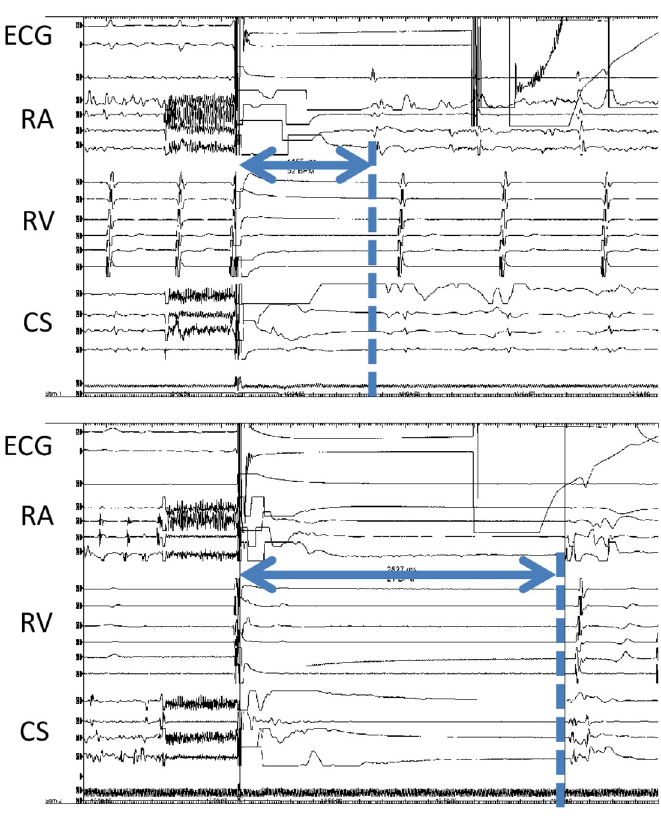
Fig 1. Measurement of the sinus node recovery time. RA, right atria; RV, right ventricular; CS, coronary sinus.